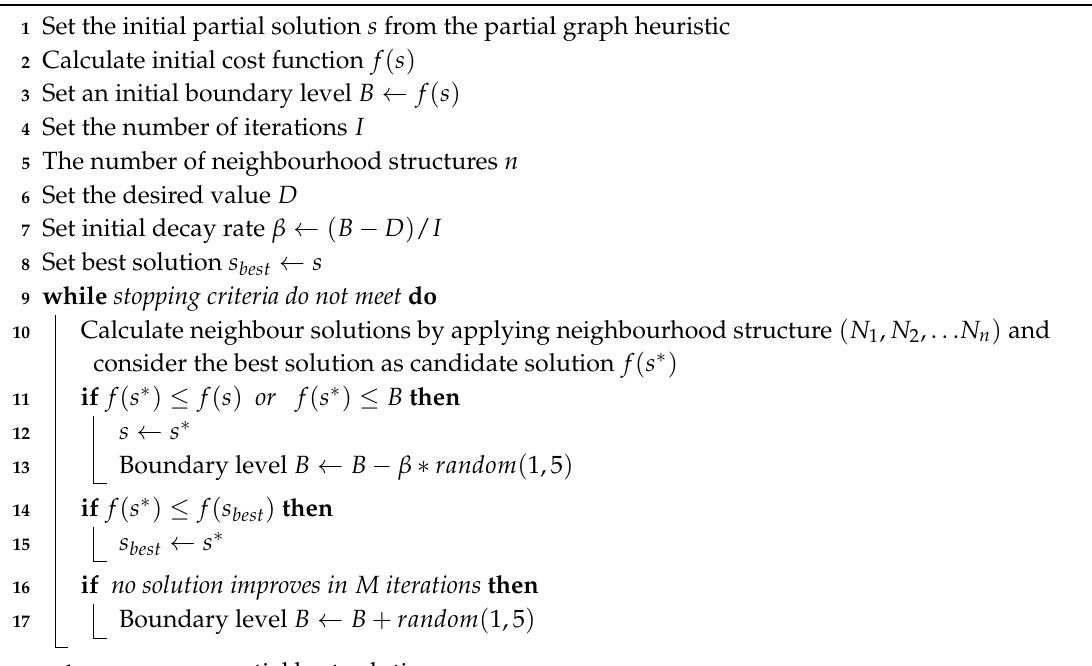
Algorithm 5: Modified GD for improvement of partial scheduled